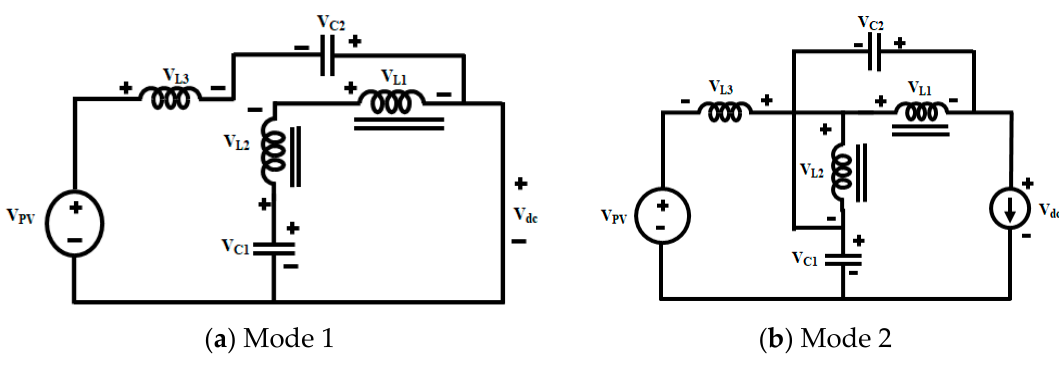
Figure 4. Operating modes of the SCDB converter .